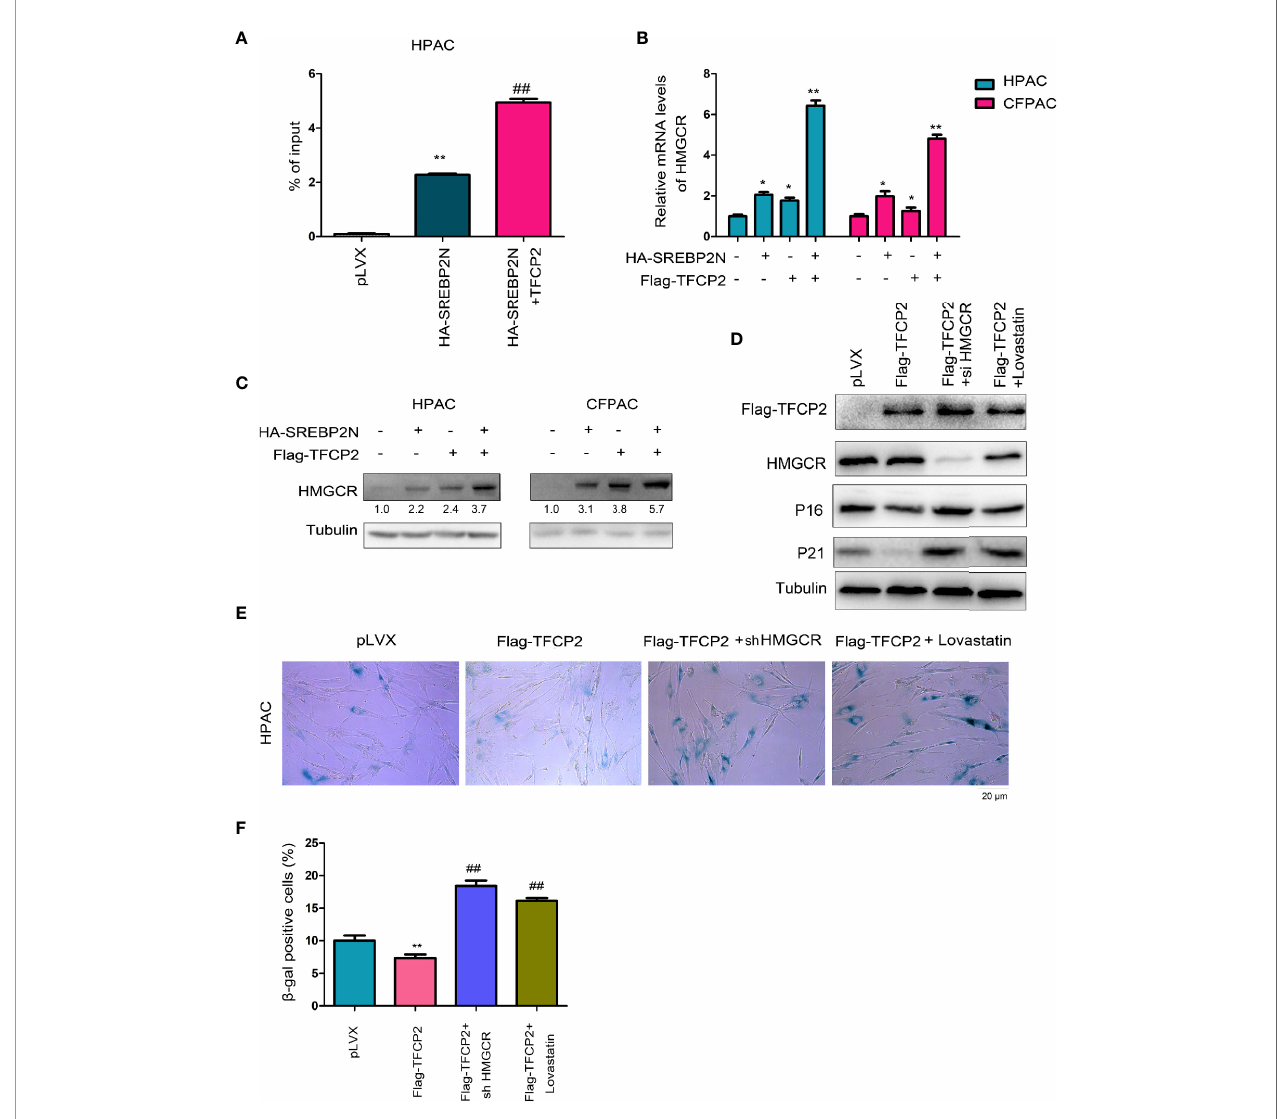
FIGURE 6 | TFCP2 cooperated with SREBP2 to activated cholesterol synthesis. (A) ChIP assay was performed to examine the binding of SREBP2 with HMGCR promoter. ## P < 0.01; ** P < 0.01. (B) qPCR was performed to examine the mRNA levels of HMGCR. * P < 0.05; **, P < 0.01. (C) Western blot was performed to examine the protein levels of HMGCR. (D) Western blot was performed to examine the protein levels of P16, P21, TFCP2 and HMGCR. The concentration for Lovastatin was 20 µM. (E) b -Gal staining was performed to evaluate the senescence. The concentration for Lovastatin was 20 µM. (F) Statistical analysis for (E) . ## P < 0.01; ** P <